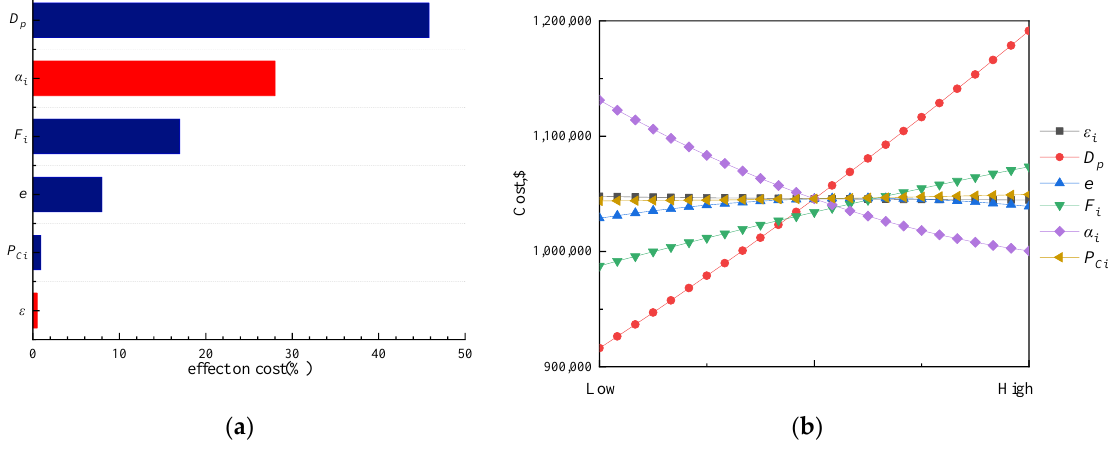
Figure 17. Parametric analysis of design variables to cost. ( a ) Pareto diagram; ( b ) main effect plot.